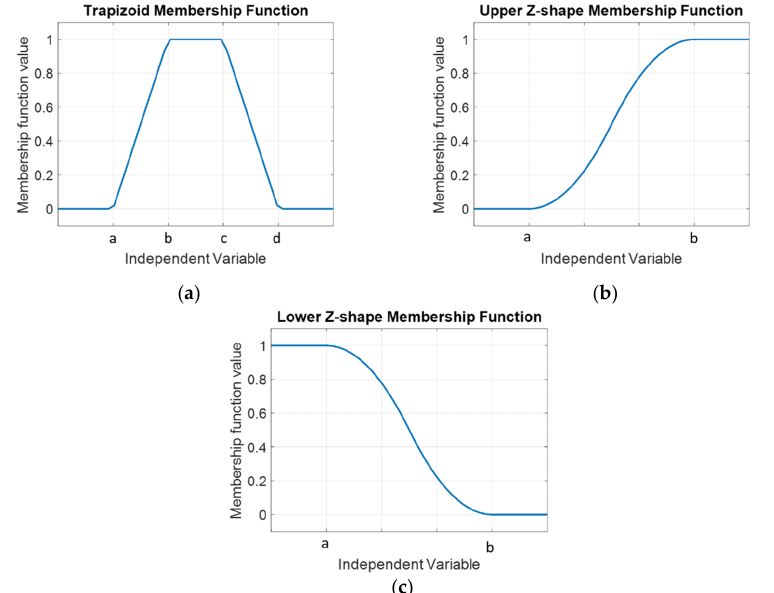
Figure 3. Membership functions used for fuzzy-sets. ( a ) Trapezoidal-shape membership function. ( b ) Z-shape membership function for upper bound. ( c ) Z-shape membership function for lower bound.